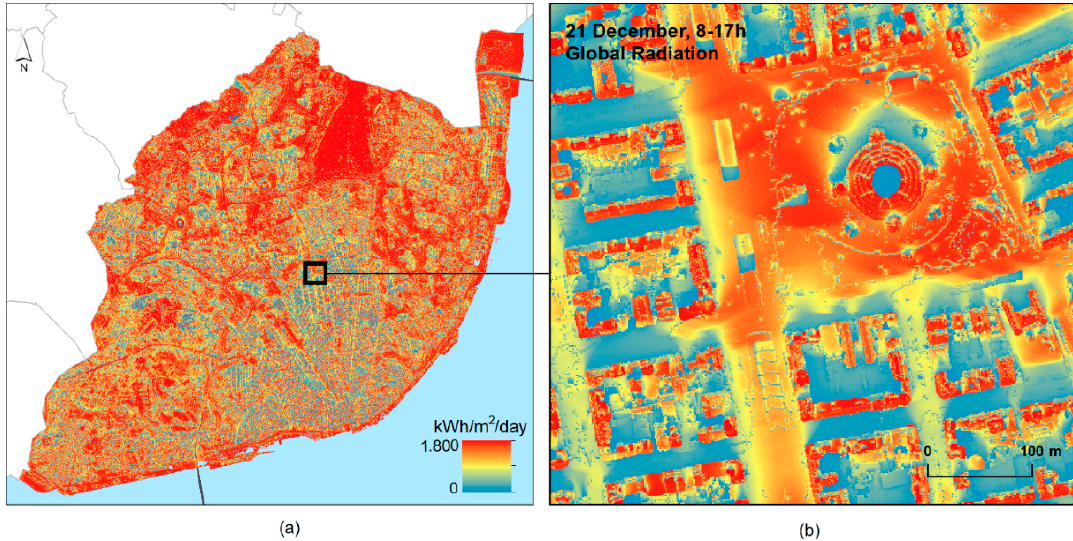
Figure 5. Map of the Global Radiation for the 21st December ( a ), and a neighborhood close-up ( b ) .